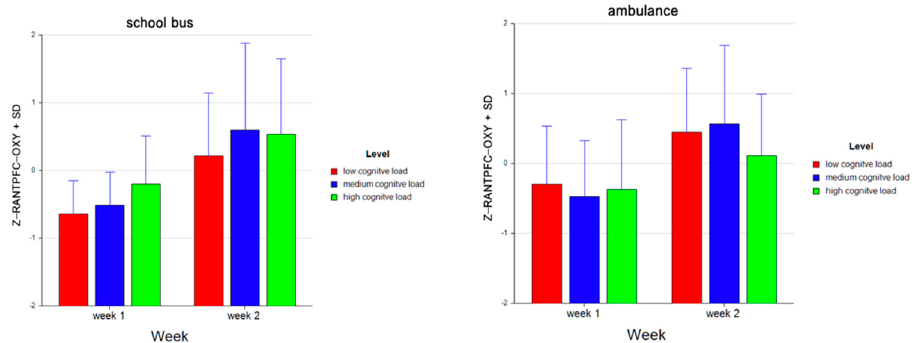
Figure 20. Bar charts represent average standardized z-scores for oxygenation for right anterior prefrontal cortex (Z- RANTPFC-OXY) and standard deviation (SD) for low cognitive load, medium cognitive load, and high cognitive load tasks for experiment Week 1 and Week 2 (left) and School Bus and Ambulance problem scenarios (right).